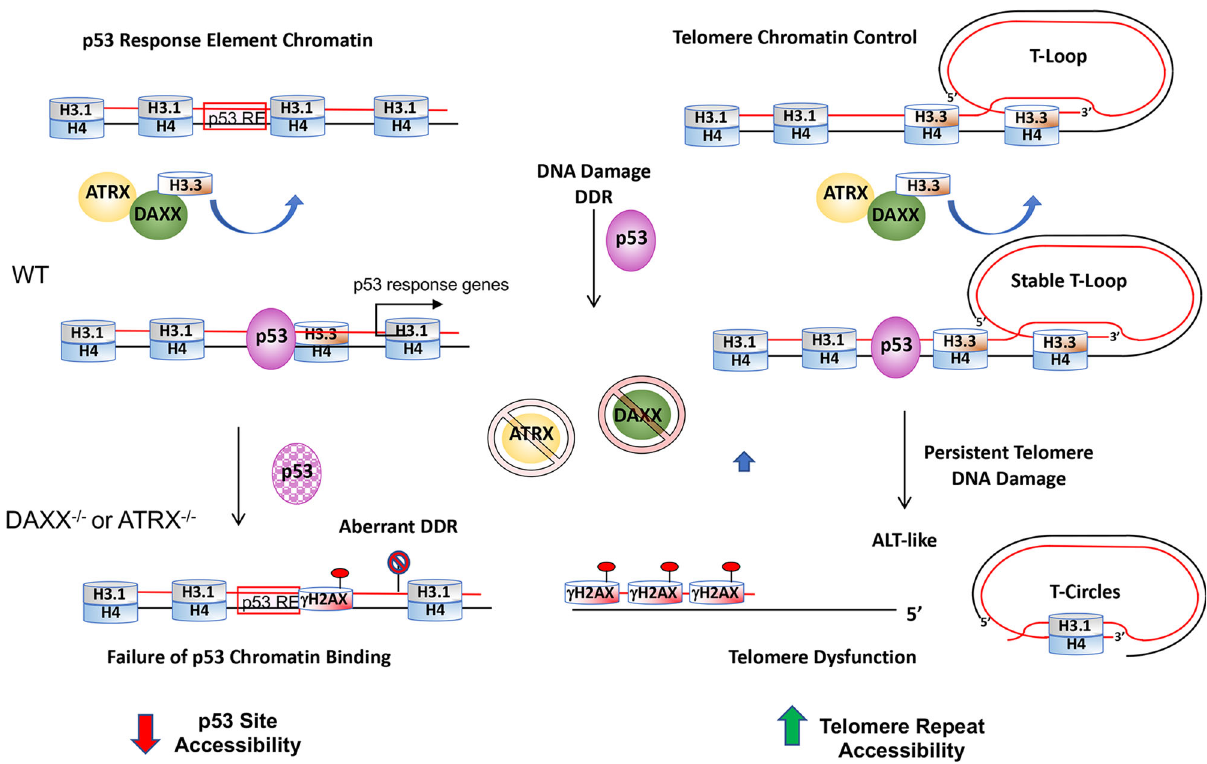
Fig.8|ModelofATRXandDAXX-dependenteffectsonchromatinaccessibility at p53-response elements and telomeres. ATRX and DAXX loss of function mutations lead to a change in p53 chromatin binding and protein stability in U87 glioblastomacellmodel.LossofATRXorDAXXreducesp53chromatinbindingand transcriptional activation of DNA-damage response genes, such as GADD45A and